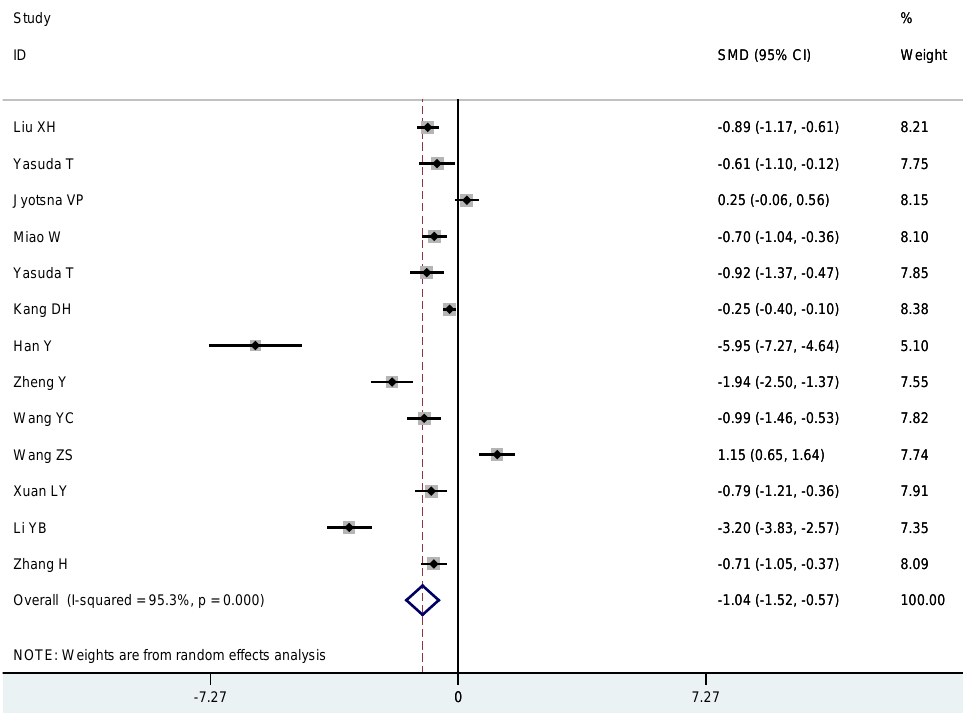
Figure 4. Meta-analysis of studies (chronologically ordered) reporting 25(OH)D levels in Graves’s disease vs. controls, standardized mean difference with 95% confidence